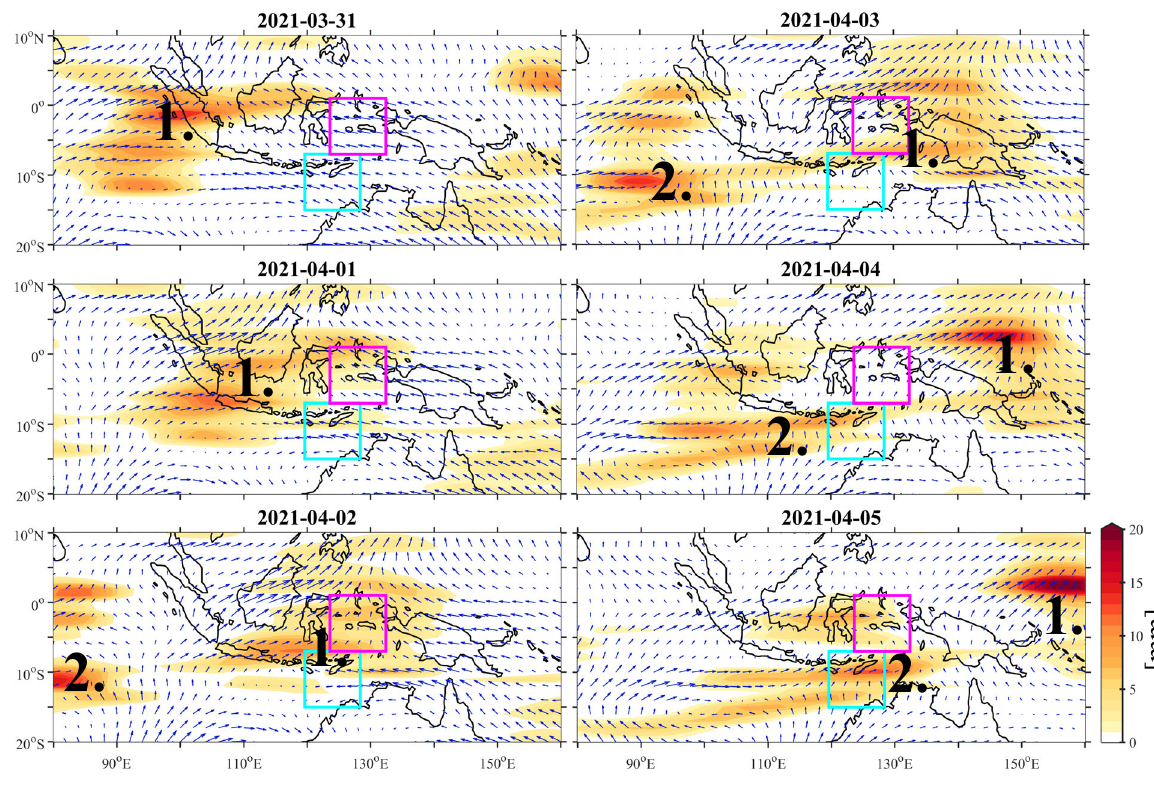
Fig. 6 | Time evolution of GPM precipitation anomalies (shaded) and ERA-5 850hPa winds (arrows) during the Tropical Cyclone Seroja genesis. Anomalies are wavenumber-frequency fi ltered for Convectively Coupled Kelvin Waves. All